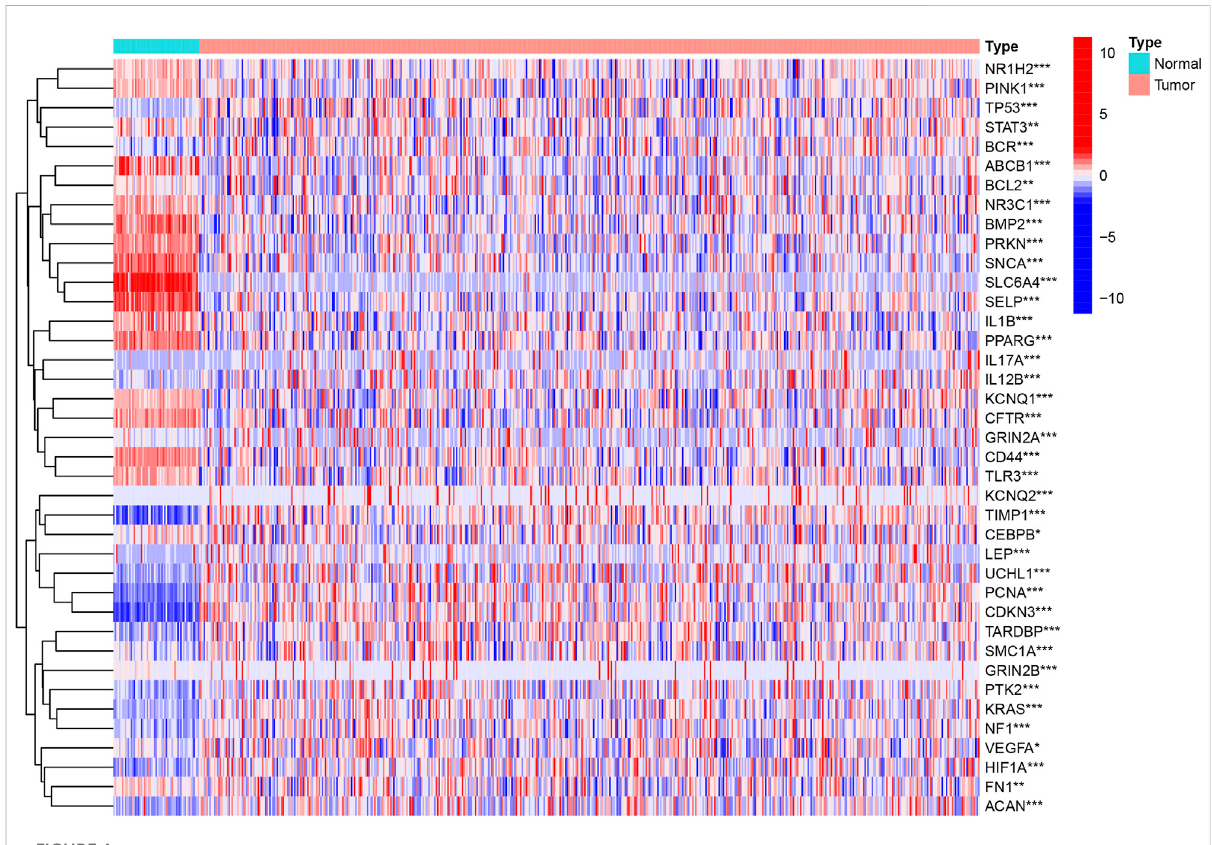
FIGURE 1 Identi fi cation of the UPP-related DEGs. The heatmap analysis of the top 39 DEGs between the tumor and normal